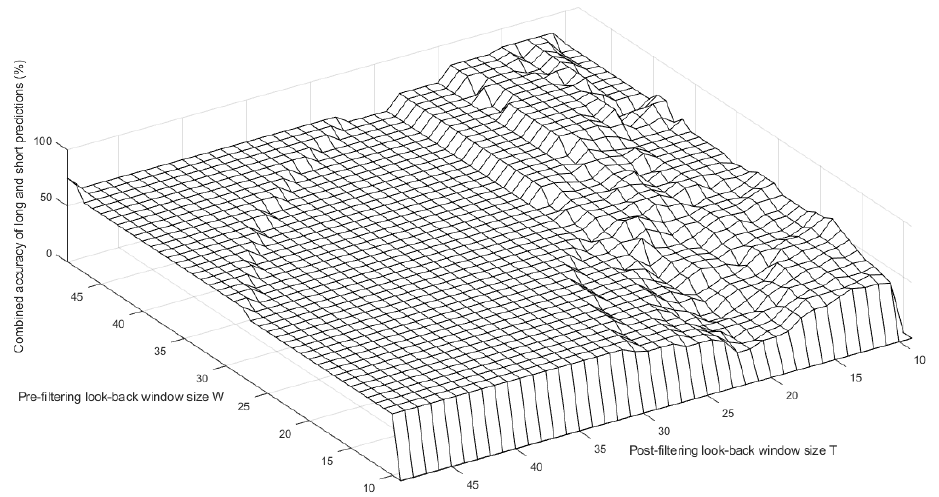
Figure 9. Surface (mesh) plot of the combined long/short predictive accuracy as a function of the pre- and post-filtering look-back window sizes W and T , respectively, for Eruo-Dollar (USA) daily (averaged) exchange rates from 29/04/2008 to 27/02/2012 as given in Figure